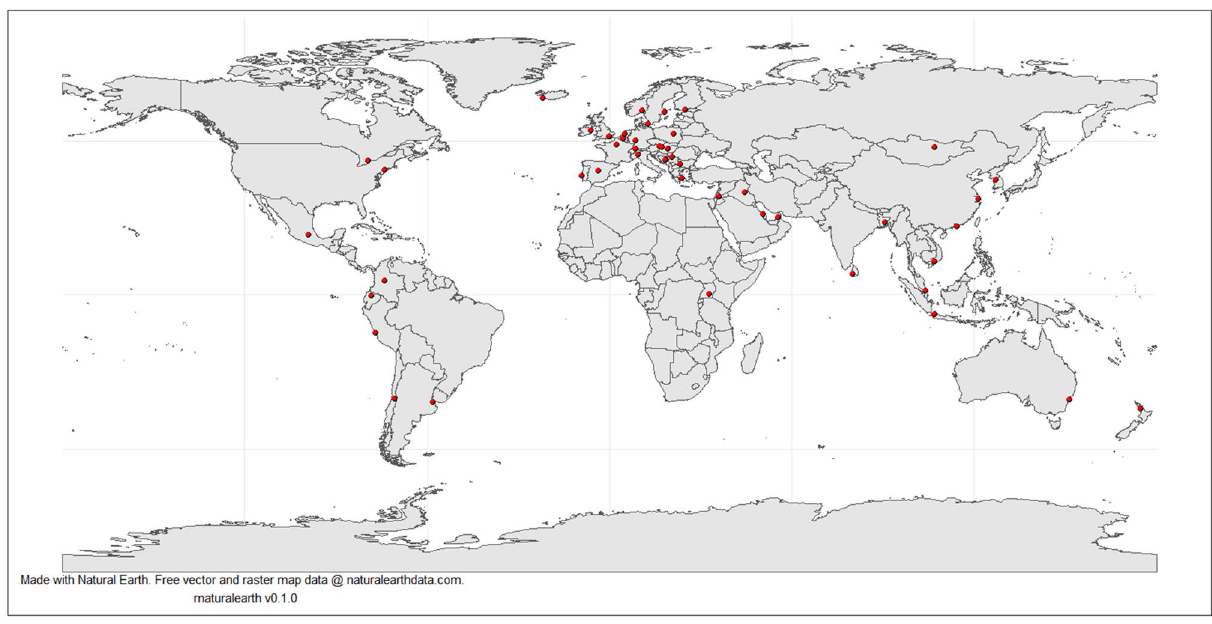
Figure 3. Geographical coverage of the